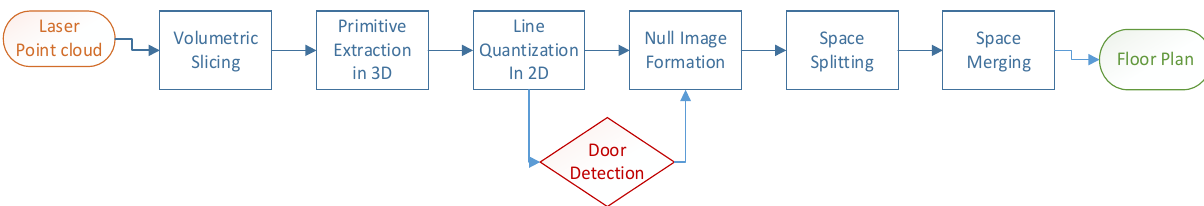
Figure 1. The overview of the